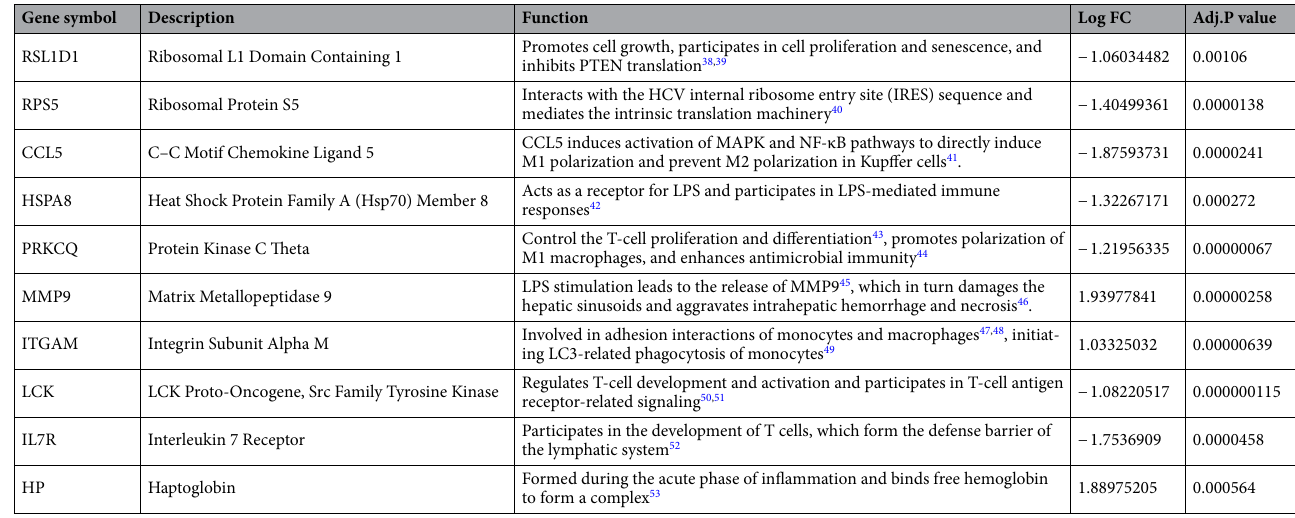
Table 3. Description of hub